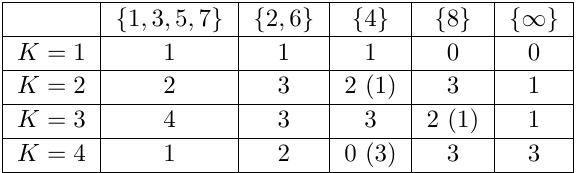
Table 5 . Number of Bethe roots for decomposed BAE with M =